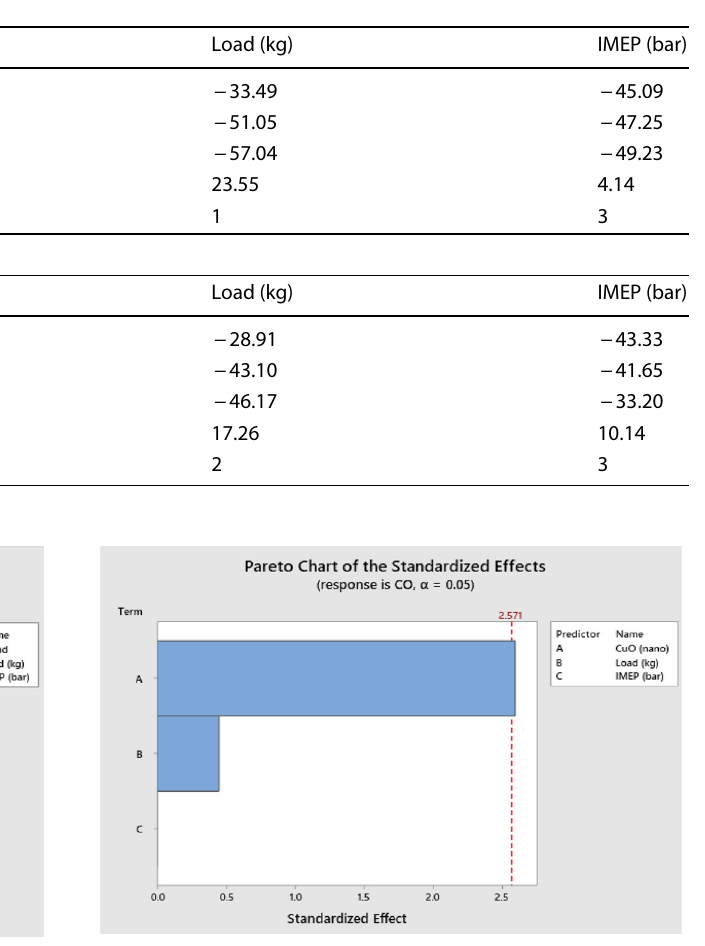
Fig. 13 Regression analysis: CO versus CuO (nano), load (kg), IMEP (bar) with